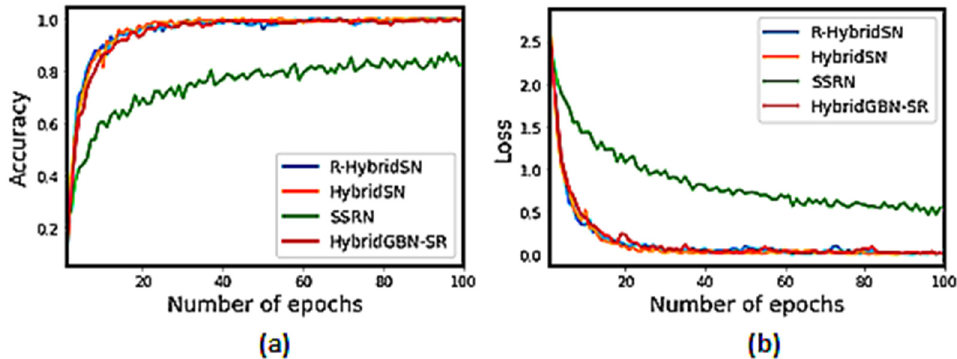
Figure 12. Training graphs for R-HybridSN, HybridSN, SSRN, and HybridGBN-SR for each epoch over SA dataset: (a) The training accuracy graph; (b) The loss convergence graph